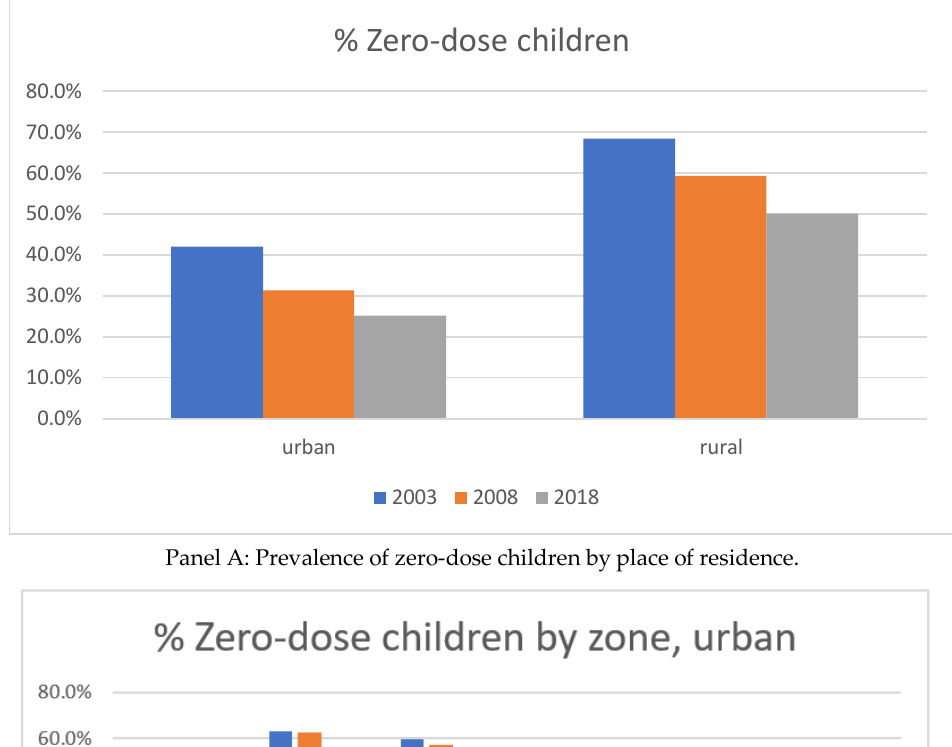
Panel A: Prevalence of zero-dose children by place of residence.